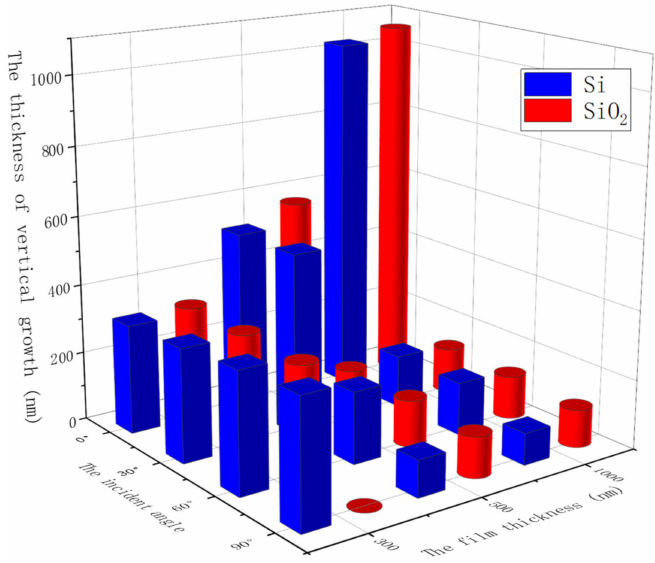
Figure 4. Vertical growth thickness of columnar structures of films on different